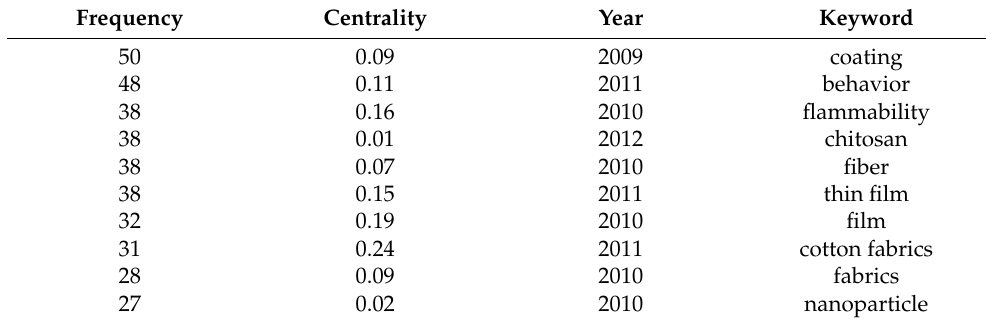
Table 1. Top 10 effective keywords in LbL self-assembly coating on fabric ranked by frequency and centrality. Frequency Centrality Year Keyword 50 0.09 2009 coating 48 0.11 2011 behavior